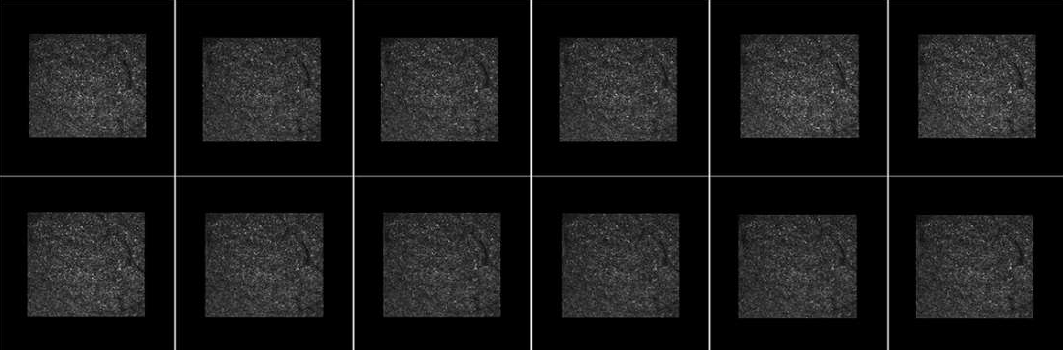
Figure 13. AOSLO image stabilization results under slow drifts. The first image is the first frame in the sequence.